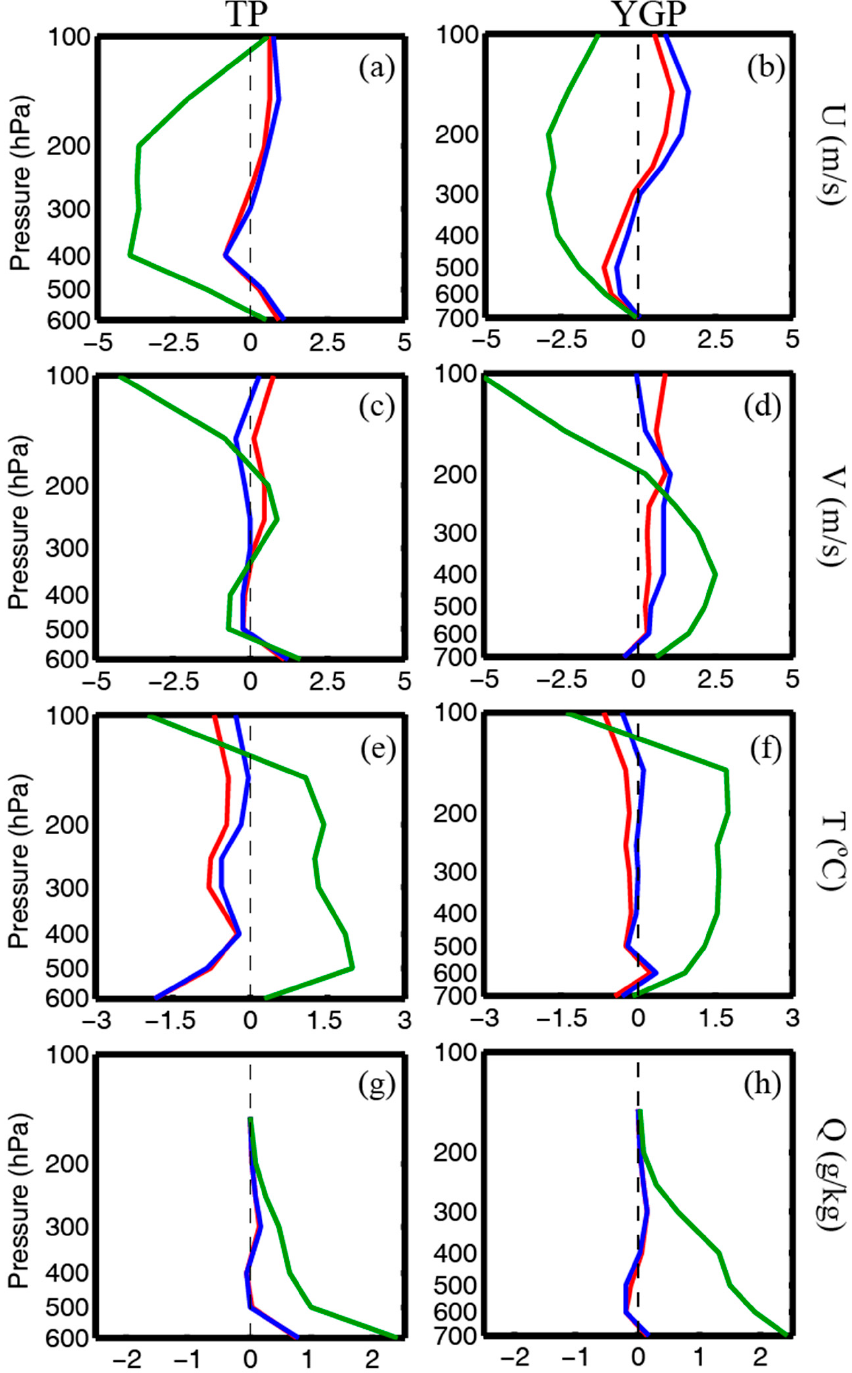
Figure 3. Vertical profiles of the mean biases of ( a , b ) U, ( c , d ) V, ( e , f ) T, and ( g , h ) Q averaged over the independent soundings at ( left ) TP and at ( right ) YGP, respectively, for each reanalysis against the observations during the 2008 JICA/Tibet Project IOP.